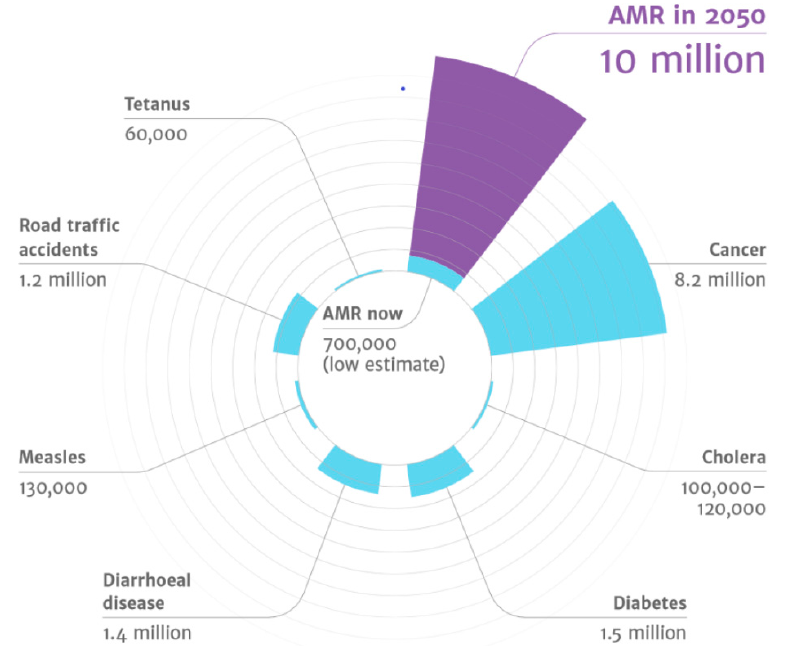
Figure 1. The main causes of death by 2050 [7].